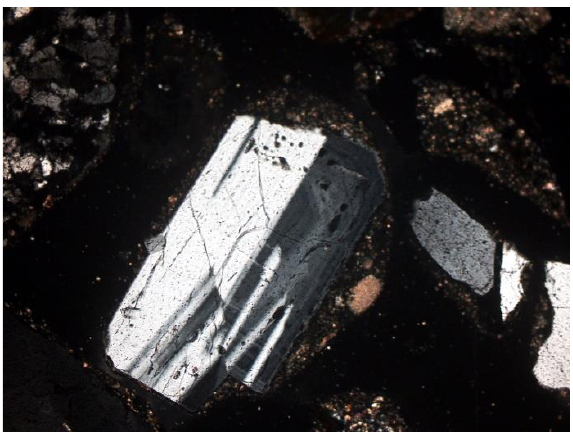
Figure 10. Plagioclase — visible multiple twinning and residual zonal structure. SP3 sample, thin section, 2P, 100×, transmitted light.